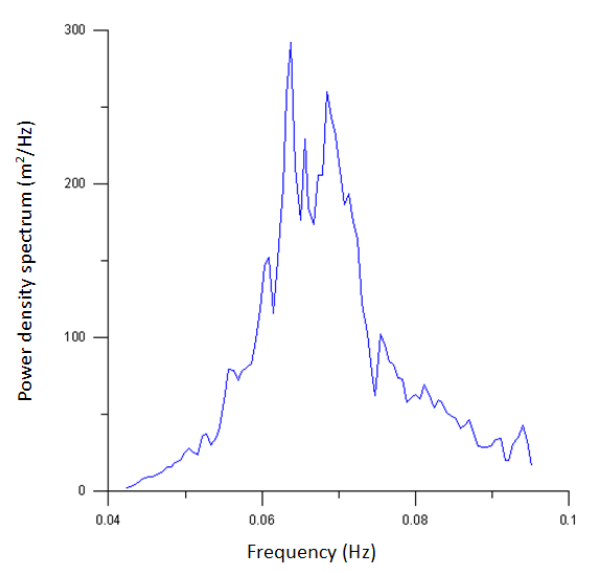
Fig. 3. Power density